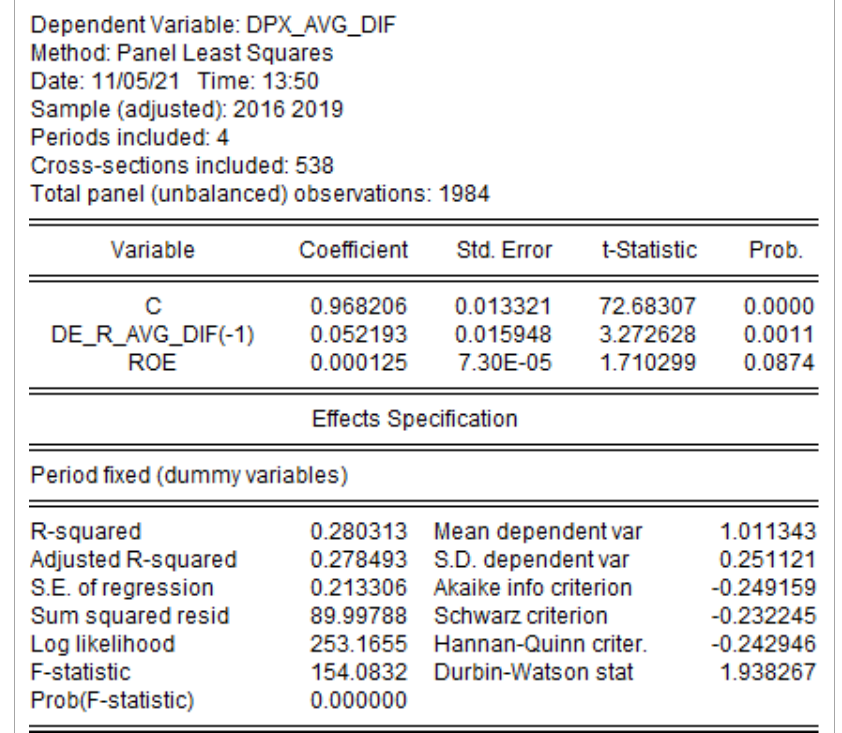
Figure 8. OLS regression estimation (EViews